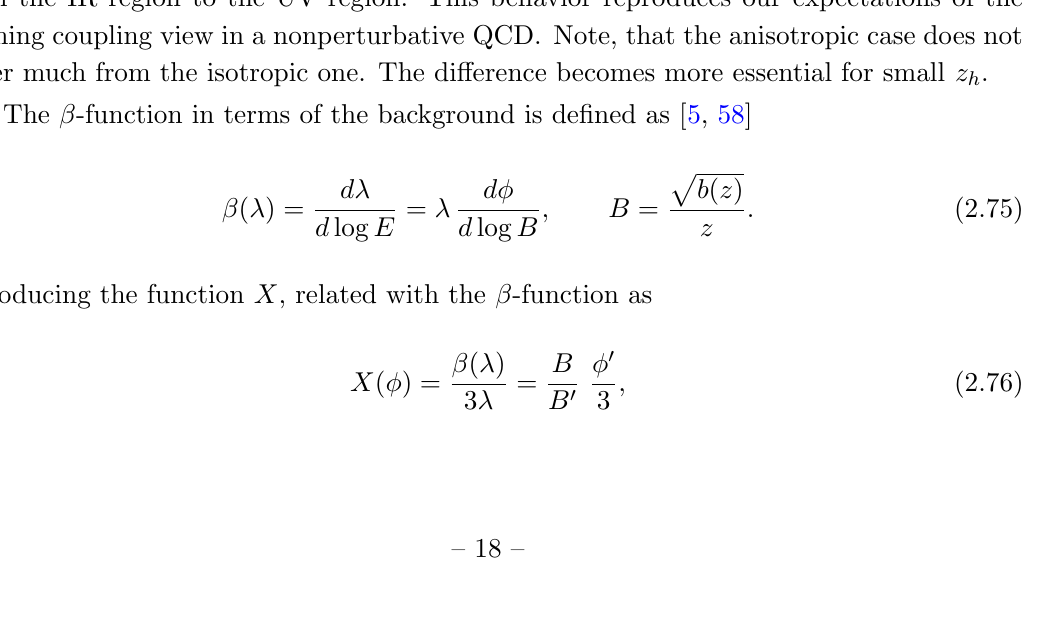
(cid:21) = (cid:20)(cid:21) . In (cid:12)gure 11.A we show the dependence of coupling constant on the energy t